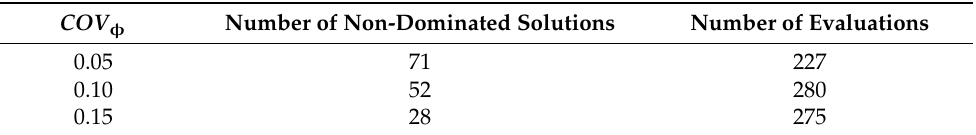
Figure 7. The relation between a normalised hypervolume and the number of evaluations of the modified RGD procedure. Table 9. The required number of evaluations and the number of non-dominated solutions of the modified RGD